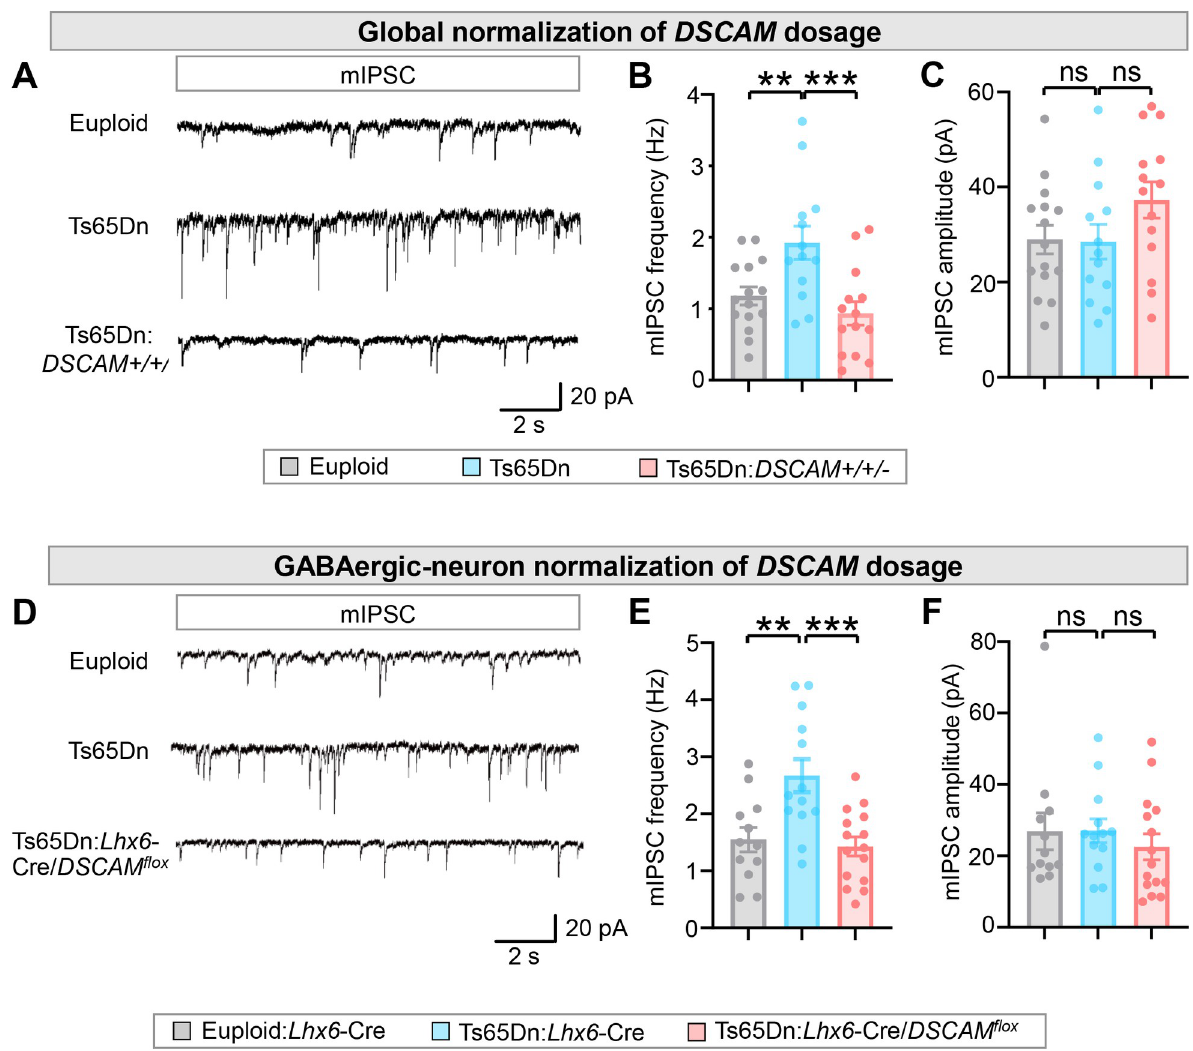
Fig 2. Normalizing DSCAM levels rescues the enhanced GABAergic synaptic transmission in Ts65Dn neocortex. ( A-C ) Global normalization of DSCAM gene dosage in Ts65Dn mice. mIPSCs were recorded from brain slices from euploid, Ts65Dn, and Ts65Dn: DSCAM+/+/− mice, which were obtained by mating female Ts65Dn and male DSCAM 2j mice. ( A ) Representative traces of mIPSCs from PyNs in layer II/III of the ACC. ( B, C ) Quantification of mIPSC frequency ( B ) and amplitude ( C ). A total of 6 euploid control, 6 Ts65Dn, and 6 Ts65Dn: DSCAM+/+/− mice were analyzed. For each mouse, 2–4 PyNs were recorded. ( D - F ) Normalization of DSCAM gene dosage in GABAergic neurons in Ts65Dn mice. Lhx6 -Cre mice were crossed with DSCAM flox mice to generate Lhx6 -Cre: DSCAM flox mice in the Ts65Dn background (Ts65Dn: Lhx6 -Cre: DSCAM flox ). ( D ) Representative traces of mIPSCs from PyNs in layer II/III of the ACC in euploid: Lhx6 -Cre, Ts65Dn: Lhx6 -Cre, and Ts65Dn: Lhx6 -Cre: DSCAM flox brain slices. ( E, F ) Quantification of mIPSC frequency ( E ) and amplitude ( F ). A total of 4 euploid control, 4 Ts65Dn, and 4 Ts65Dn: Lhx6 -Cre: DSCAM flox mice were analyzed. For each mouse, 2–4 PyNs were recorded. One-way ANOVA for multigroup comparisons and post hoc Student t tests for pair-wise comparisons. ** : p < 0.01; *** : p < 0.001; ns: not significant ( p > 0.05). The data underlying this Figure can be found in https:// doi.org/10.5281/zenodo.7714234. ACC, anterior cingulate cortex; DSCAM, Down syndrome cell adhesion molecule; mIPSC, miniature inhibitory postsynaptic current; PyN, pyramidal